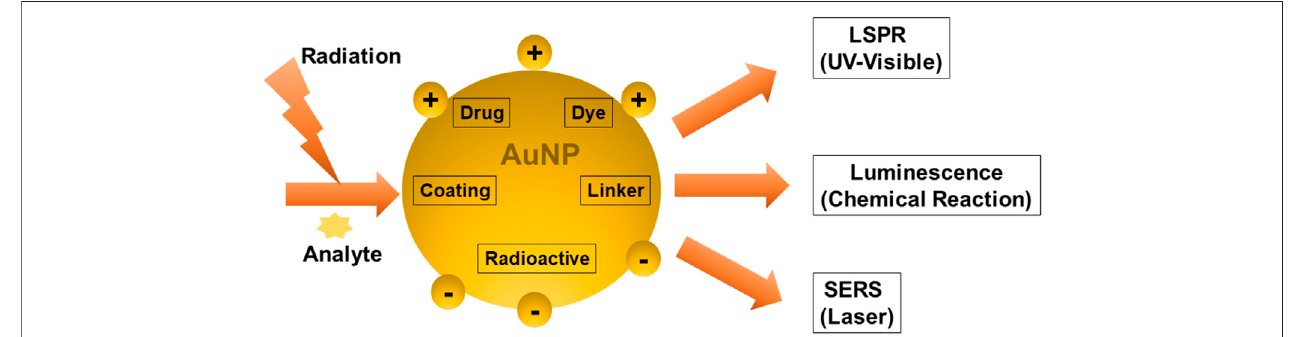
FIGURE 6 | Techniques to analyze the Surface plasmon properties of multifunctional AuNPs.